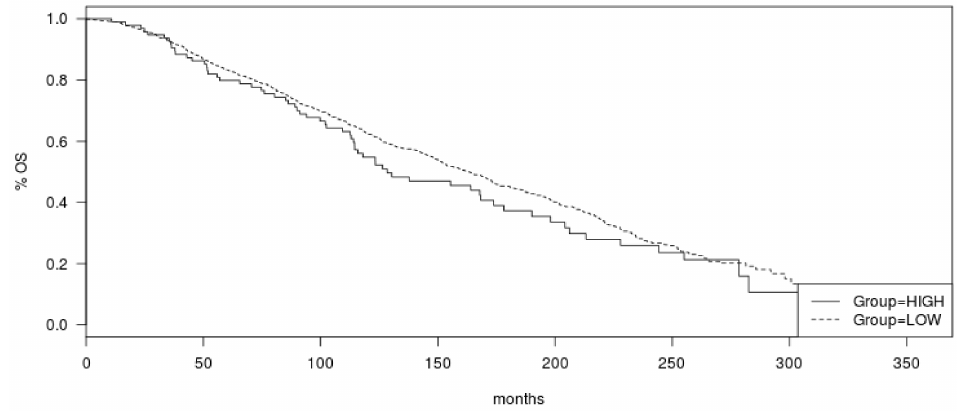
Figure 5. Overall survival (OS) of ER-positive/HER2-negative breast cancers according to total mutation count in the METABRIC cohort. Log Rank p = 0.28.